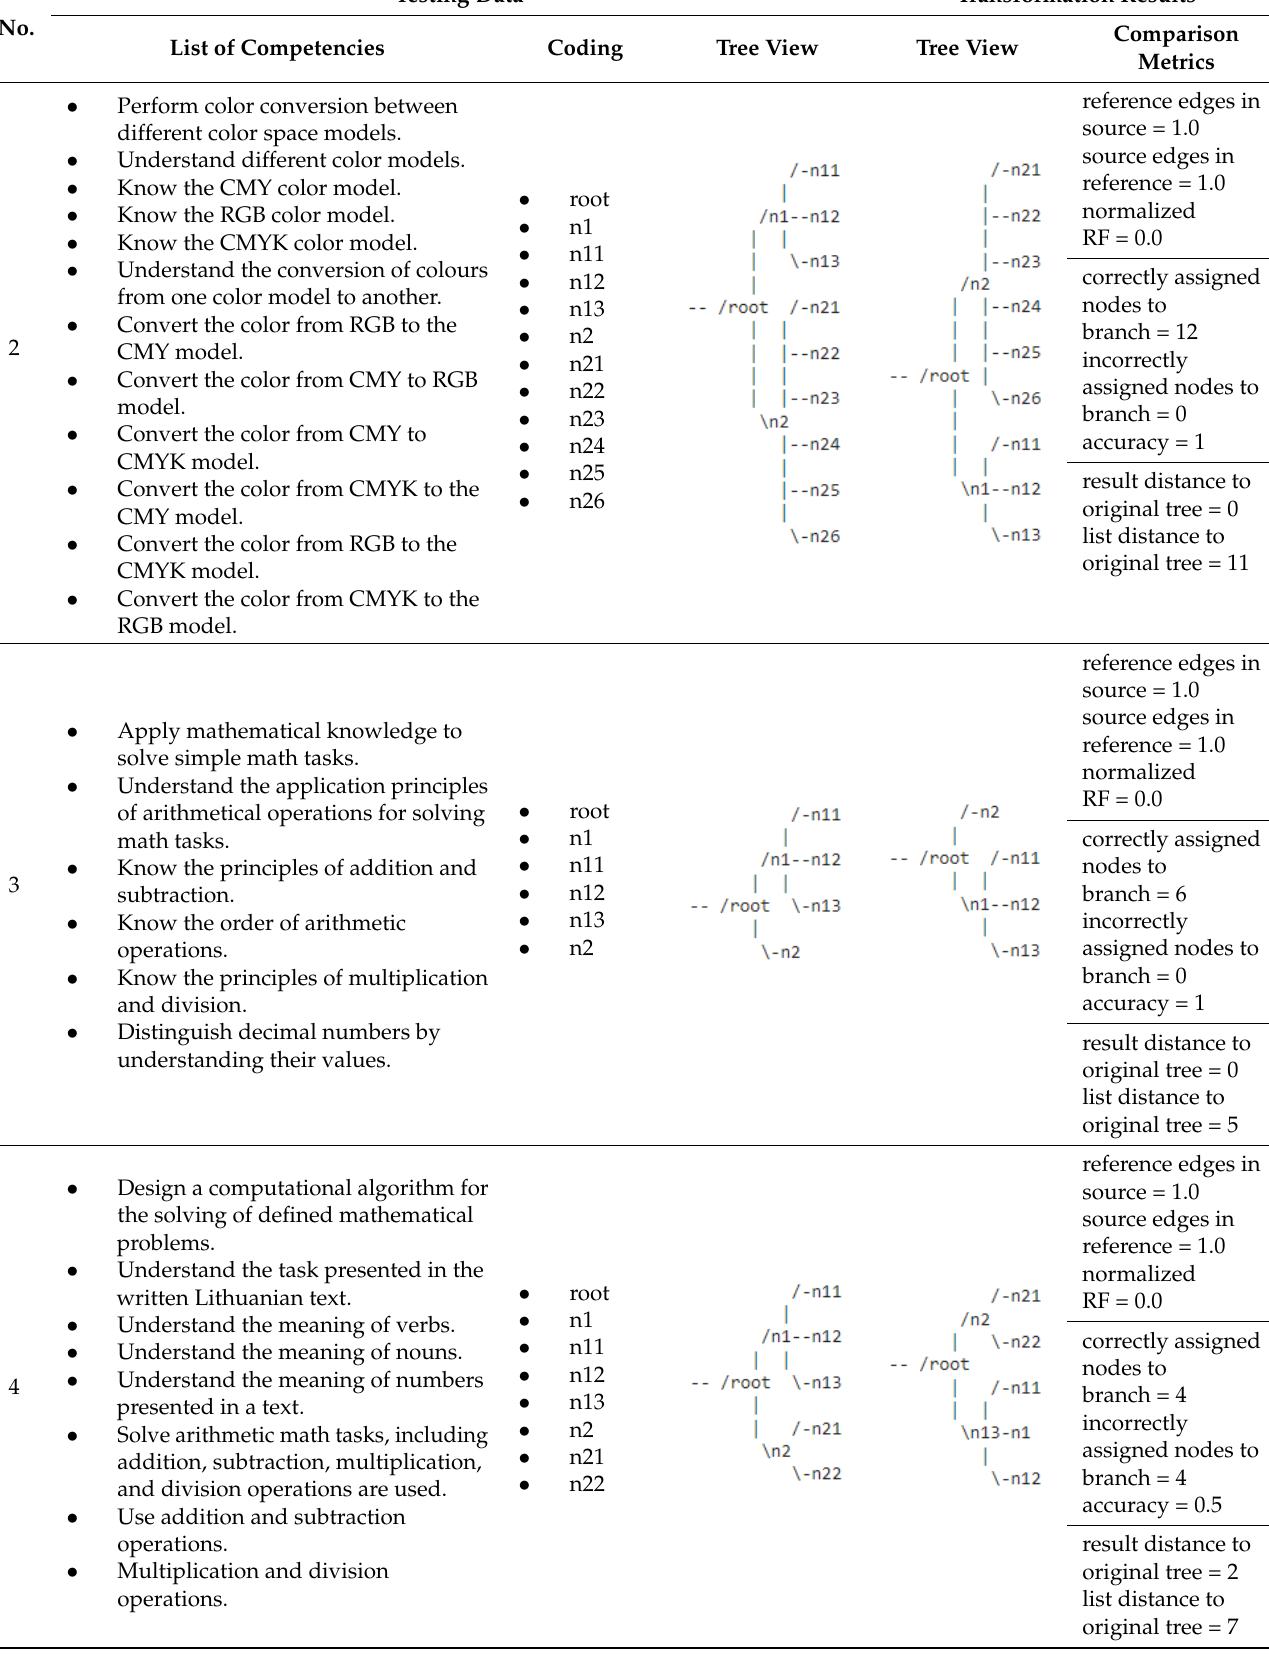
Table A1. Cont. Testing Data Transformation Results Coding Tree View Tree View